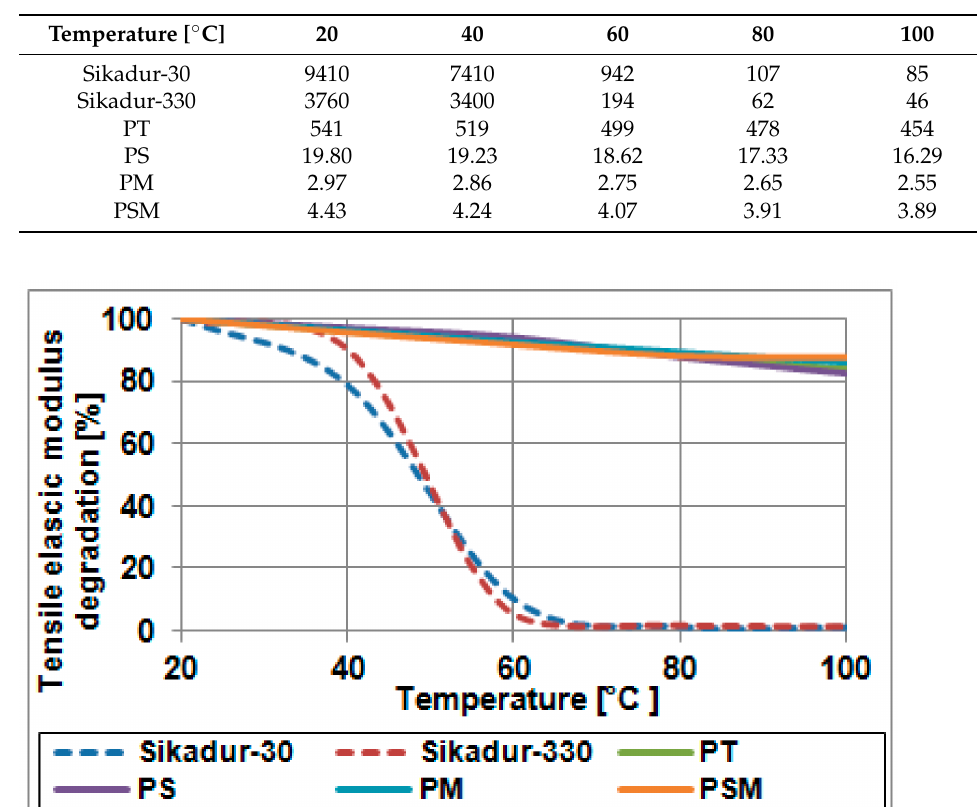
Figure 1. The tensile elastic modulus degradation in elevated temperatures (compare—Table